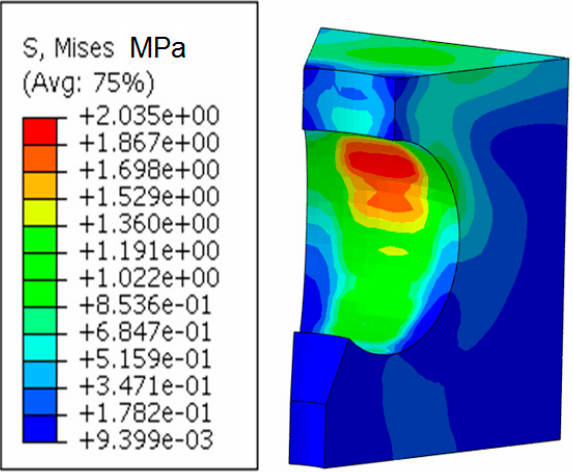
Figure 16. Stresses in the concrete massif.